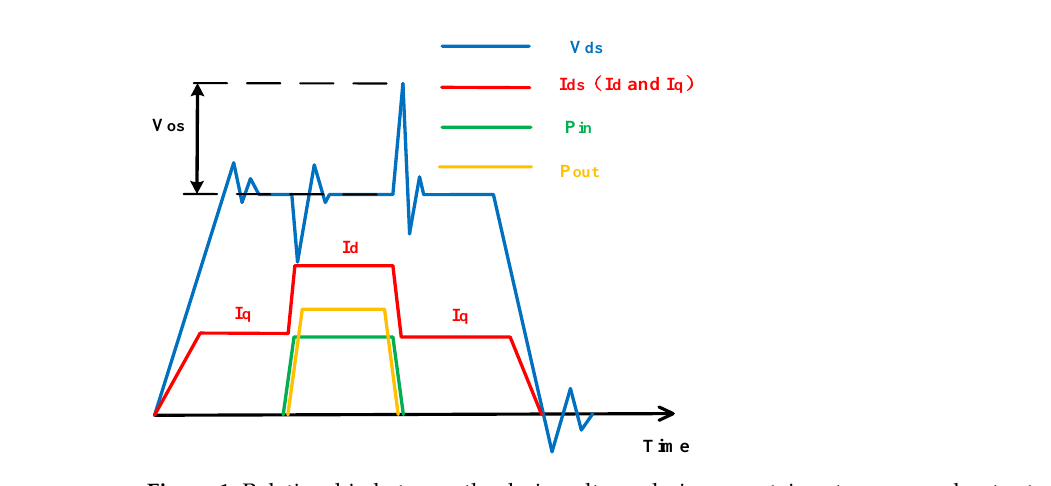
ceives the microwave through the transmission line. In bias lines with radial stubs at one end, microstrip lines with a length of λ /4 are employed [12]. Impedances that are per- ceived by the device at the drain side in this configuration are open to odd harmonious frequencies and short to even harmonious frequencies [13]. As a result, the bias circuit allows the power supply to deliver a DC or pulsed voltage to the power amplifier without transmitting microwave signals to the power supply. The parasitic inductance of the conventional bias circuit is illustrated in Figure 3a. The parasitic inductance is the combination of the bias line and a portion of the transmis- sion line. By reducing the bias line ’ s length and increasing the transmission line ’ s width, the proposed bias circuit can decrease the bias circuit ’ s parasitic inductance, as illustrated in Figure 3b. L TT L BT ( b ) Figure 3. The graphical depiction of the parasitic inductance of the bias circuit. ( a ) The traditional bias circuit. ( b ) The proposed bias network. Assume that the proposed bias circuit is symmetric and that the microwave ’ s ideal short-circuit location is the radial stub. The impedance transformation relation of the pro- posed bias circuit is shown in Figure 4. The load Z L has a 50 Ω impedance. Z 1 is the trans- mission line ’ s characteristic impedance, Z b is twice that of the bias line ’ s characteristic im- pedance, θ b is the bias line ’ s electrical length, and θ 1 is the transmission line ’ s electrical length.